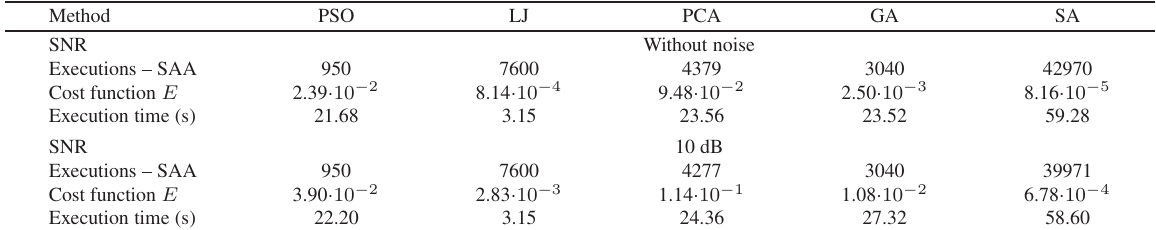
Table 1 Performance of the stochastic methods in the benchmark damage identification